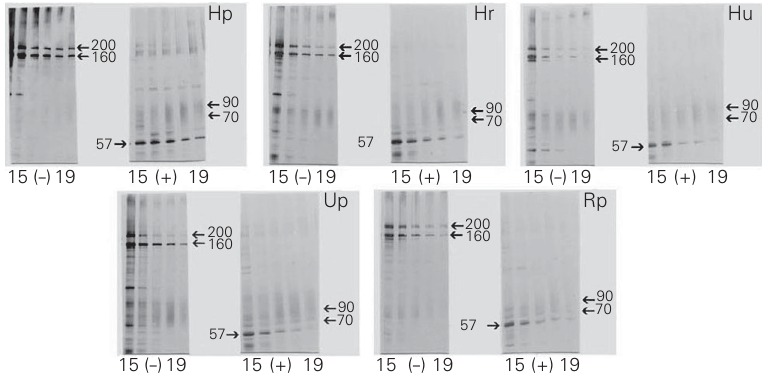
Figure 3. D4 fractions obtained from each region were separated by DEAE-Sephacel chroma- tography with NaCl gradient ranging from 0 to 1.0 M. The eluate was analyzed by SDS-PAGE. Two bands of 160 and 200 kDa and a scattered band of 70-90 kDa were observed in the absence of ß-mercaptoethanol (-). A 57-kDa band was detected in the presence of ß-